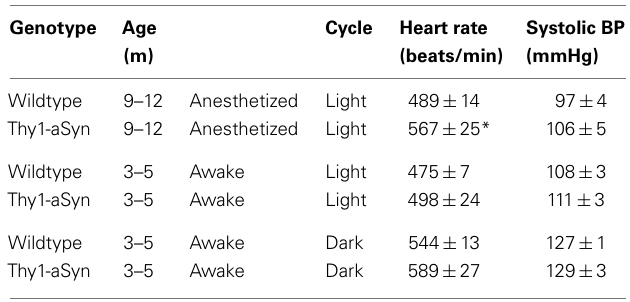
Table 2 | Baseline heart rate and blood pressure (BP) in anesthetized and awakeThy1-aSyn and wildtype